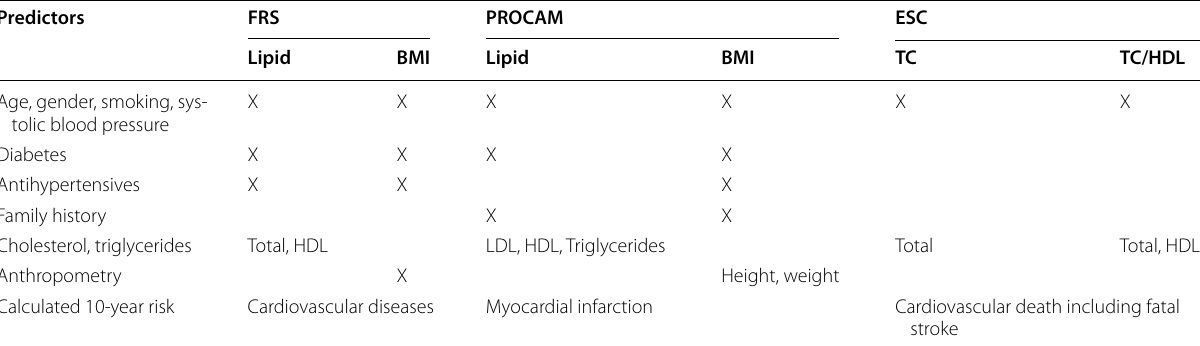
Table 1 Predictors of cardiovascular risk calculated according to the Framingham Risk Score including lipids or body mass index, the Prospective Cardiovascular Münster Study Score including lipids or body mass index, the German version of the European Society of Cardiology Score including total cholesterol or total cholesterol/high-density